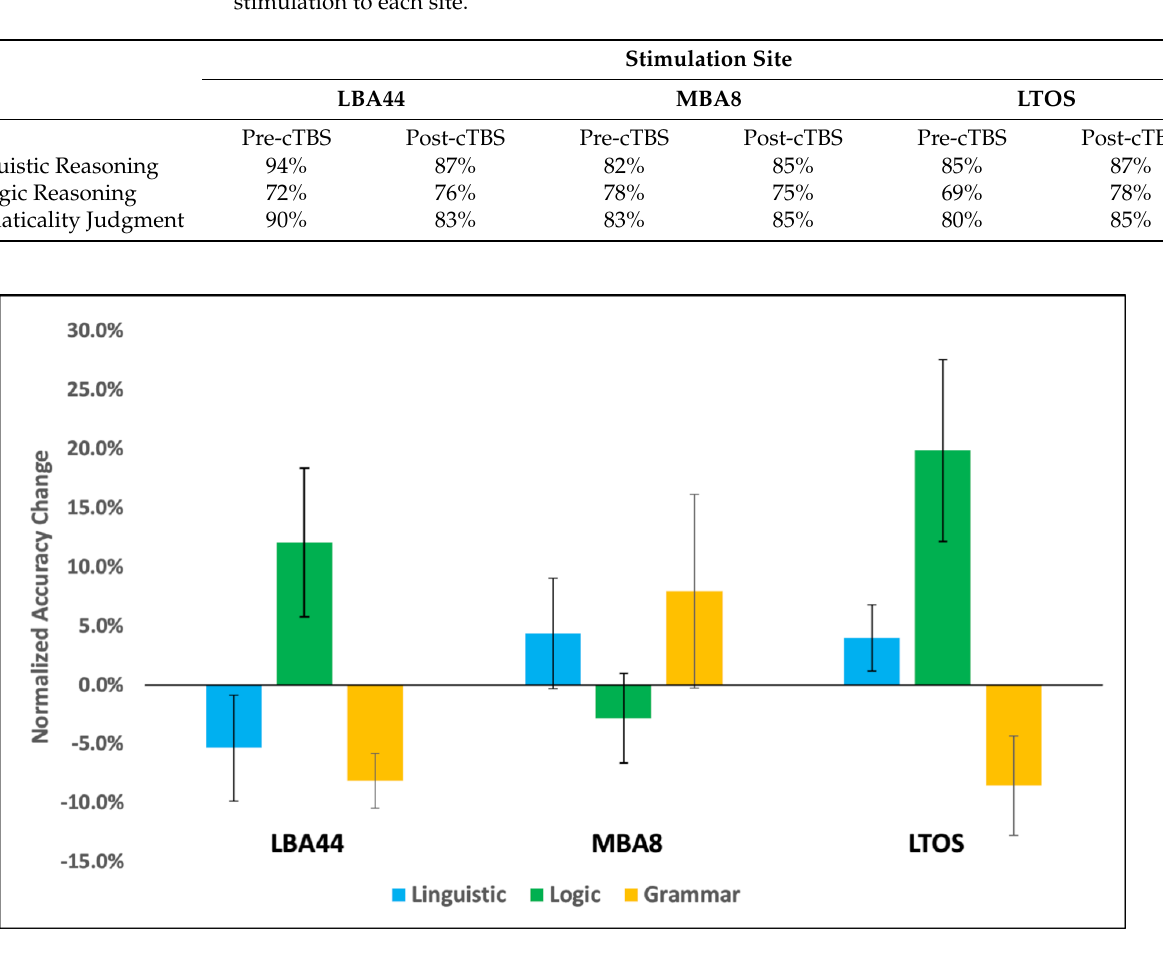
Figure 3. Normalized difference scores. Percent accuracy change for linguistic (blue) and logic (green) reasoning, and grammaticality judgments (yellow), normalized to baseline after cTBS to LBA44 ( left ), MBA8 ( middle ), and LTOS ( right ). Error bars indicate standard error.